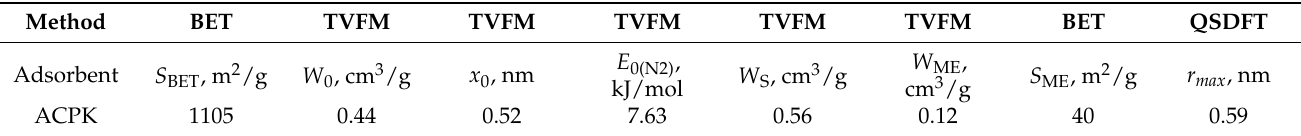
Table 3. Parameters of the porous structure of the carbon nanoporous adsorbent ACPK.